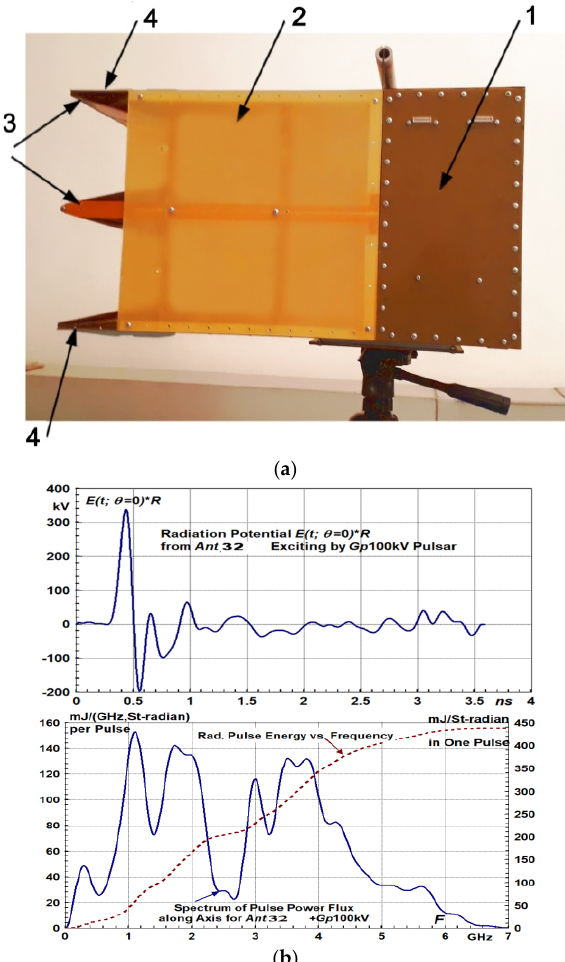
Figure 12. Radiator (R ‐ 32 cm/100 kV). ( a ) 1 = box with the pulser, DC source (accumulator assem ‐ bly), and control device; 2 = antenna unit; 3 = electrodes of the TEM horn; 4 = shielding plates. ( b ) Radiation potential measured on the antenna axis (at top) and the energy density of the frequency spectrum of this pulse (below). Figure 12b shows the radiated potential E ( t ) R on the axis of the radiator (( ER ) max = 340 kV). The width of the pulse frequency spectrum was 0.1–6 GHz. The frequency band was limited by a TDS ‐ 6604B recorder.